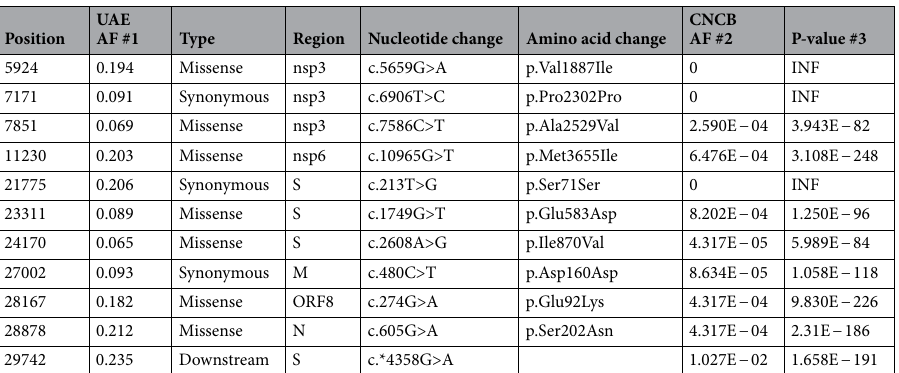
Table 1. Allele frequency and functional annotation of the eleven UAE-specific genetic variants. #1 Allele frequency computed from 896 genomes in UAE. #2 Allele frequency computed from 23,164 genomes around the globe. #3 Fisher exact test P-value comparing the allele counts between the 896 high quality UAE viral genomes and 23,164 viral genomes from the globe downloaded from the China National Center for Bioinformation. Comparison for all the 1245 variants were detailed in Table S2.